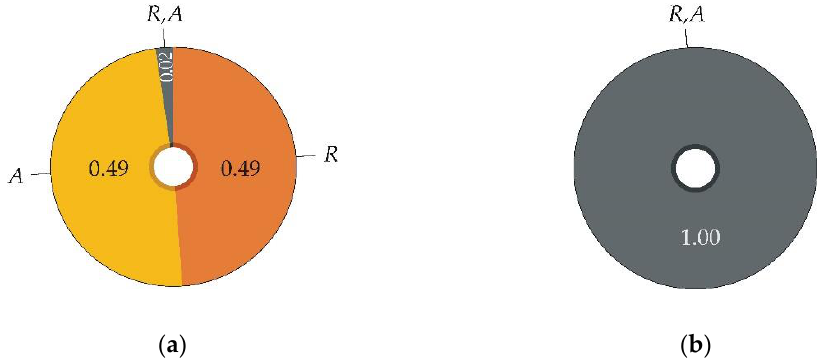
Figure 19. Global sensitivity analysis of P f from Z based on Rényi entropy: ( a ) sensitivity indices for α = 0.5; ( b ) sensitivity indices for α = 2.425.